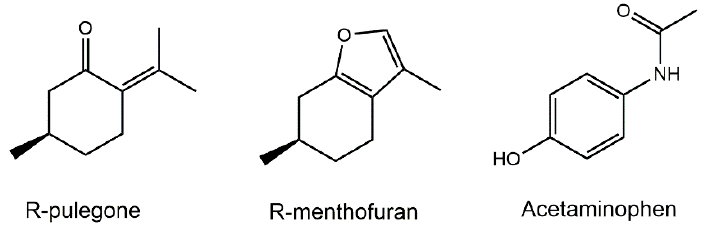
Figure 1. Structural formulas of studied monoterpenes and a reference compound acetaminophen.